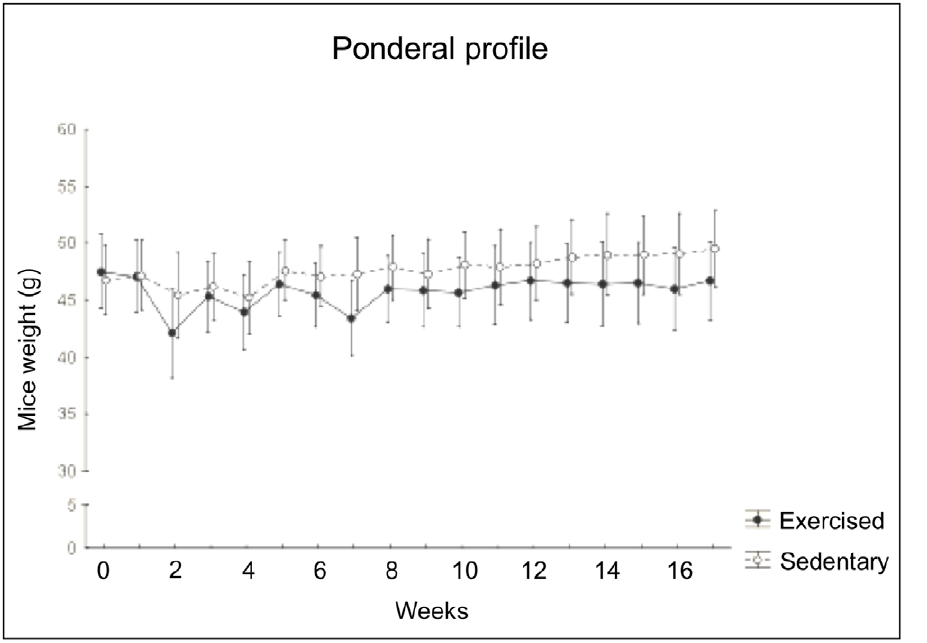
Figure 1. Ponderal profiles of mice undergoing a long-term moderate treadmill running. No significant age-dependent main effect was detected on body weight, neither did treadmill running induce significant alterations in ponderal state. Values were given as means 6 std. dev.